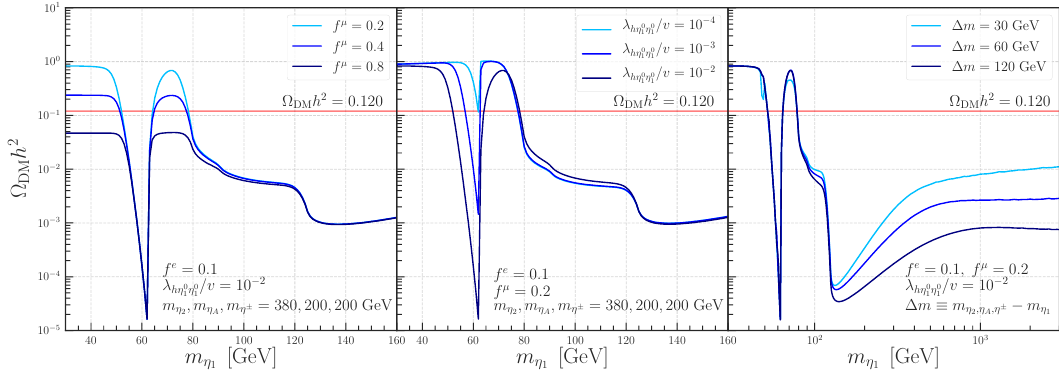
Figure 6 . Relic density as a function of the DM mass m (cid:17) 1 in the model with Y D = 1. The left, center and right panel shows, respectively, the e(cid:11)ect of varying the magnitude of the Yukawa coupling f (cid:22) , the (cid:21) coupling, and the mass splitting (cid:1) m (with m (cid:17) = m (cid:17) = m ) de(cid:12)ned in (cid:17) (cid:6) h(cid:17) 0 1 (cid:17) 0 1 2 A the (cid:12)gure. For all the panels, M (cid:31) m (cid:17) is (cid:12)xed to be 1020 GeV, while M (cid:31) m (cid:17) is taken to e (cid:0) 1 (cid:22) (cid:0) 1 be 520 (1070) [1820] GeV for f (cid:22) = 0 : 2 (0.4) [0.8] such that the g 2 anomalies can be explained (cid:0) within 1 (cid:27) level, where the latter two choices are only taken in the left